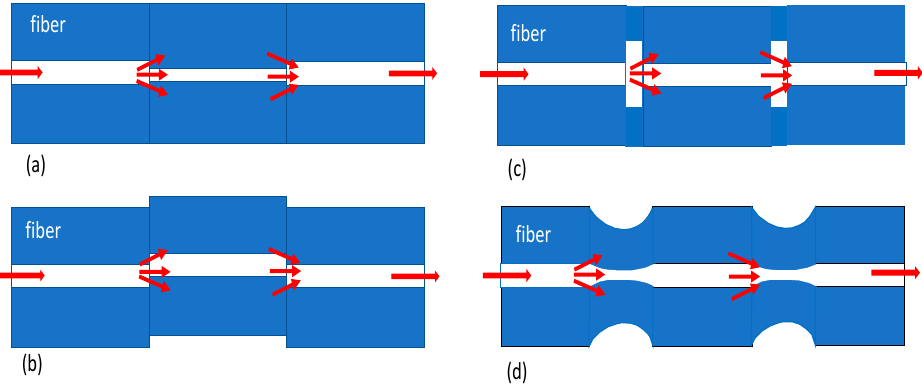
Figure 2. Various types of FOMZI sensor: ( a ) core diameter mismatch with smaller core fiber, ( b ) core diameter offset, ( c ) core diameter mismatch with larger core fiber, and ( d ) core diameter mismatch using tapering segments of fiber.